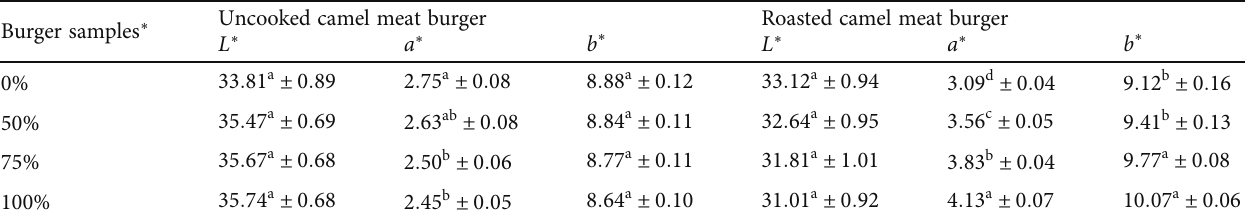
∗ Camel meat burgers partially substituted with UBDF pulp as a fat replacer, L ∗ value is a measure of lightness ranging from 0 (black) to 100 (white), a ∗ value ranges from -100 (greenness) to +100 (redness), and b ∗ value ranges from -100 (blueness) to +100 (yellowness). a,b,c No signi fi cant di ff erence ( p > 0 : 05 ) between any two means within the same column with the same superscripted letters. Table 8: Sensory characteristics of roasted camel meat burger as a ff ected by adding various levels (%) of UBDF as a fi ber source. Sensory Burger samples